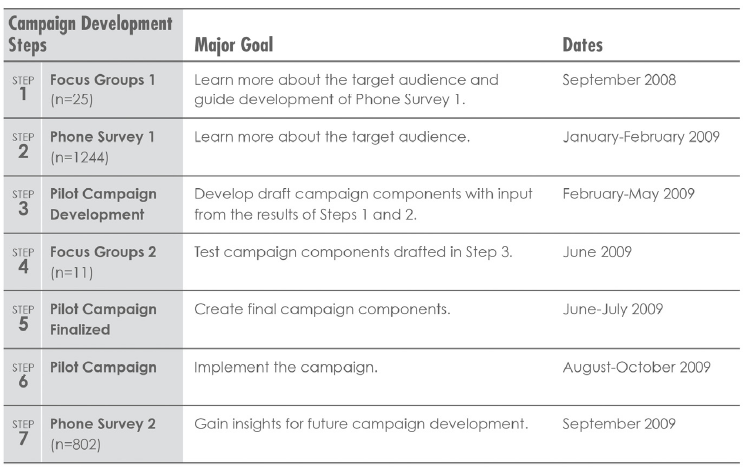
Figure 1. Food Hero development steps, goals and timeline.